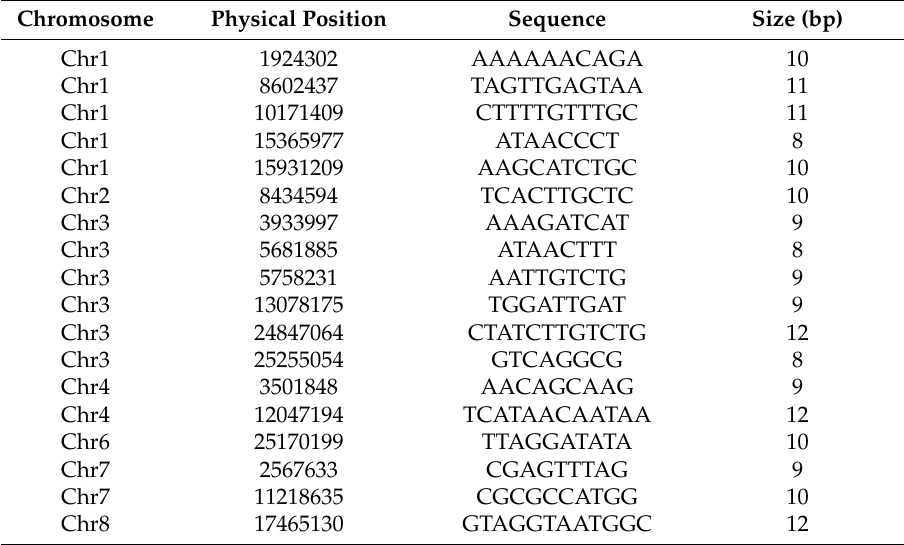
Table 4. Information about insertions of length ≥ 8 bp identified in this